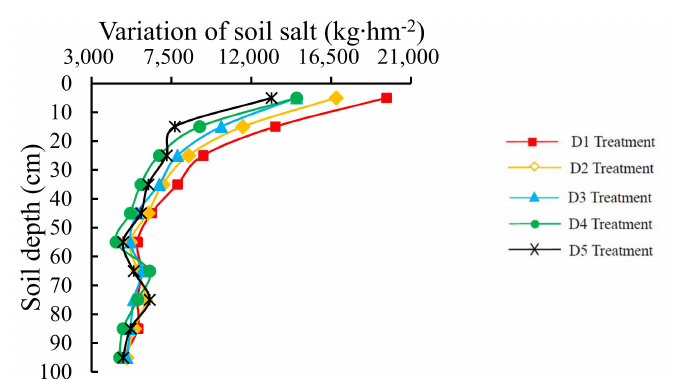
Figure 5. Variation of soil salinity inside the film.